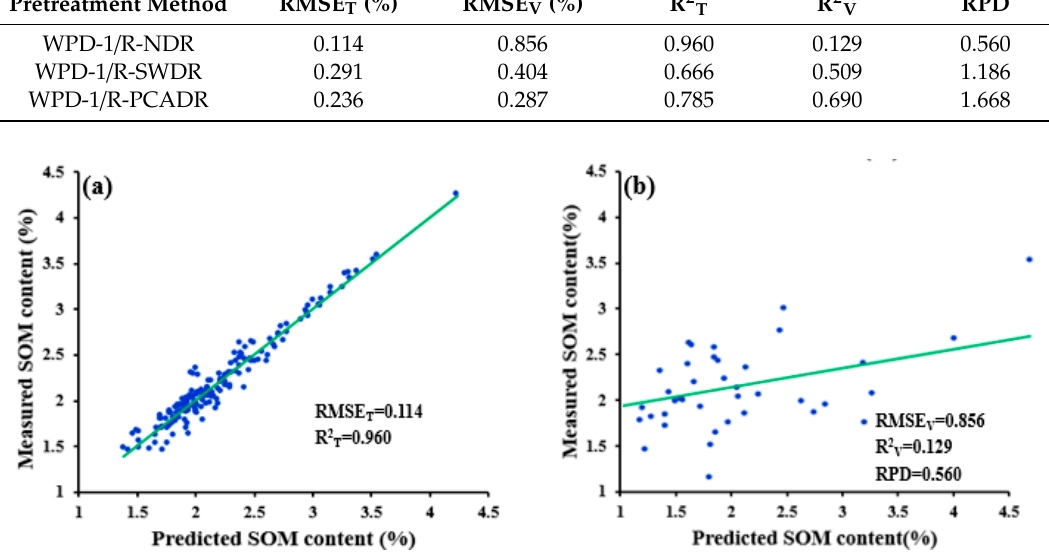
Figure 7. SOM content estimation results based on PLSR for ( a ) training and ( b ) validation set for data subjected to WPD-1/R-NDR pretreatment.